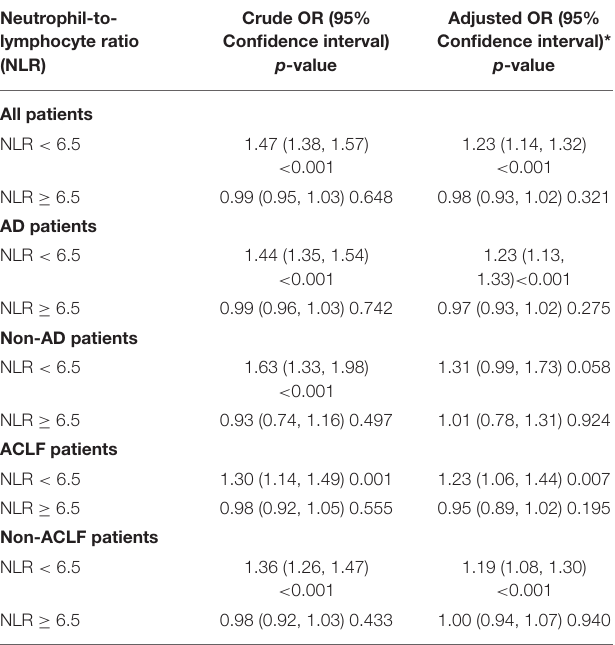
TABLE 3 | Threshold effect analysis of neutrophil-to-lymphocyte ratio on the 90-day transplant-free mortality using two piece-wise linear regression. Neutrophil-to- lymphocyte ratio